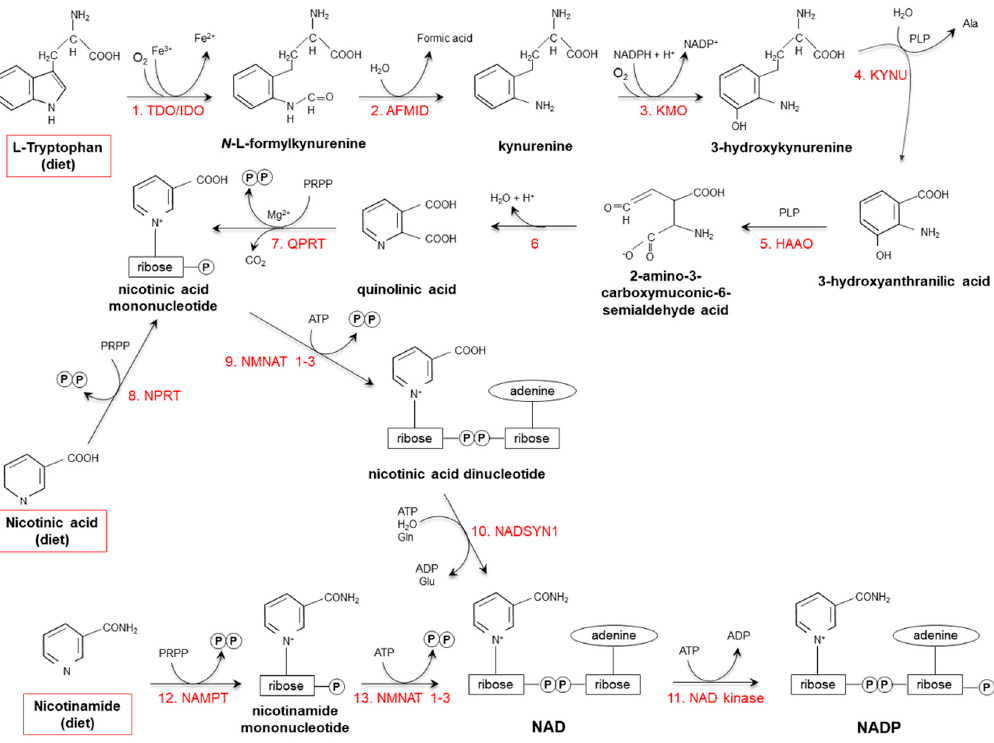
Figure 2. De novo synthesis of NAD(P) from tryptophan, nicotinamide and nicotinic acid. ( 1 ) Two iron porphyrin metalloproteins, tryptophan 2,3 dioxygenase (TDO, in the liver) and indolamine-pyrrole 2-3 dioxygenase (IDO, in extrahepatic tissues), oxidize the pyrrole moiety of Tryptophan (Trp), thus forming N -L-formylkynurenine. ( 2 ) Arylformamidase (AFMID) hydrolytically removes the formyl group producing kynurenine and is then ( 3 ) hydroxylated to 3-hydroxykynurenine by kynurenine-3 monooxygenase (KMO), a mitochondrial flavo-enzyme that uses O 2 as a substrate and NADPH as a cofactor. The action of ( 4 ) kynureninase B (KYNU, a vitamin B 6 -dependent enzyme) and ( 5 ) 3-hydroxyanthranilic dioxygenase (HAAO, a nonheme iron-dependent dioxygenase) leads to condensates and rearranges to form quinolinic acid; then, ( 7 ) quinolinic acid is decarboxylated and